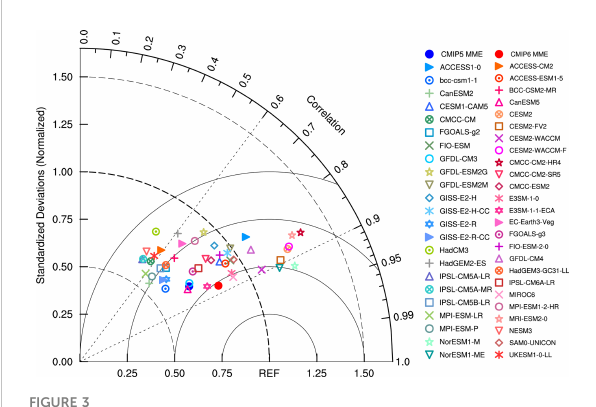
FIGURE 3 Taylor diagram of the simulated FMA mean Indian Ocean EUC from the CMIP5 and CMIP6 models compared with the corresponding observations. Colored markers indicate the results for the MME and individual models. The radius is the spatial standardized deviations normalized by the reference observations. The solid circles represent the root-mean-square difference relative to the reference value. The angular coordinates shown by dotted lines denote spatial correlations of +0.6 and +0.9.